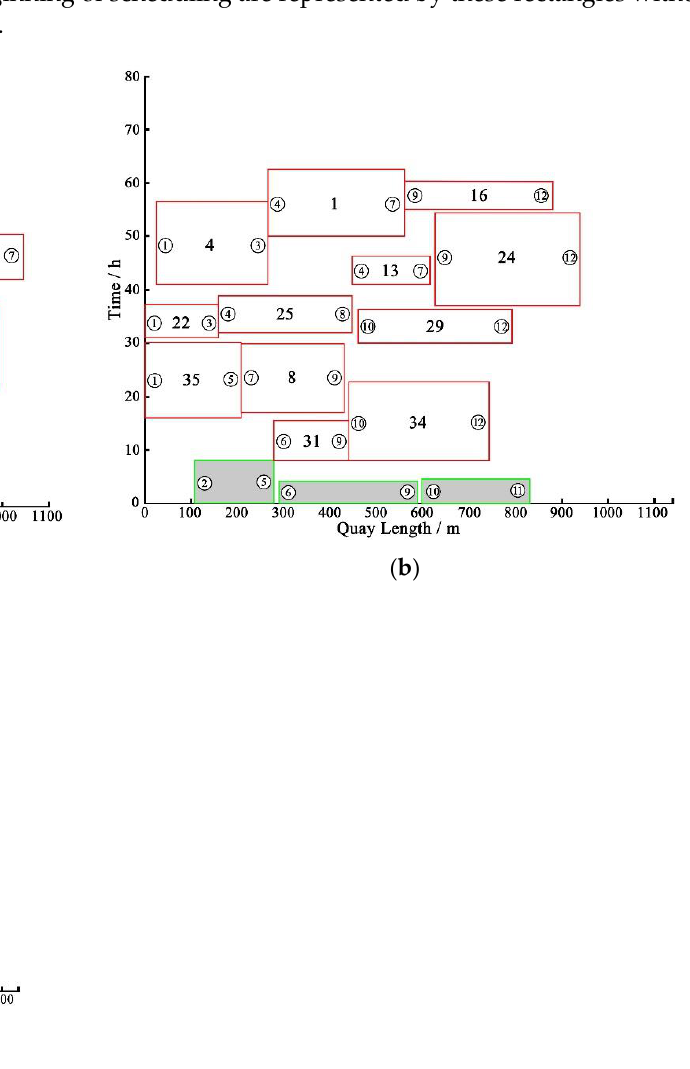
Figure 8. The scheduling solution under S + U. ( a ) terminal 1; ( b ) terminal 2; ( c ) terminal 3. (Source: compiled by authors).